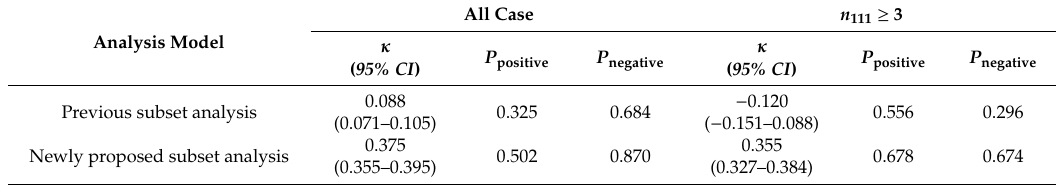
Table 5. The similarity between the Ω shrinkage measure model and subset